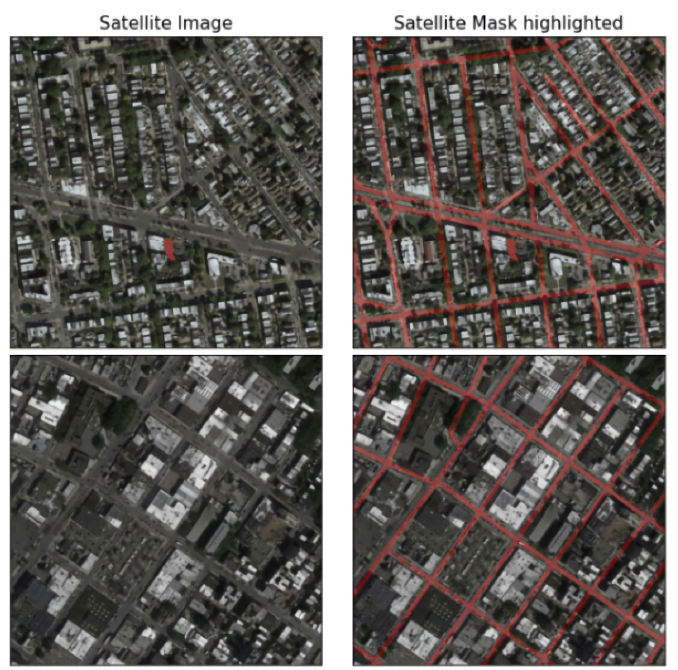
Figure 5. The binary masks are colored red and overlaid onto the satellite image to visualize the roads in the satellite images. This is useful to visualize the